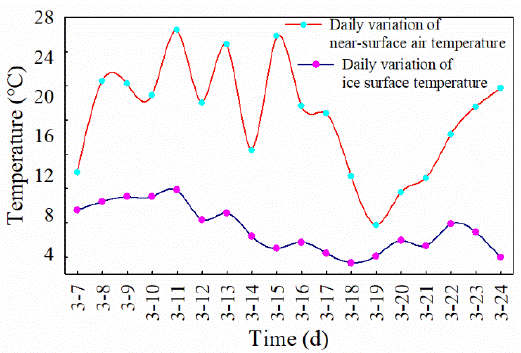
Figure 8. Daily variation of near-surface air and ice surface temperature.